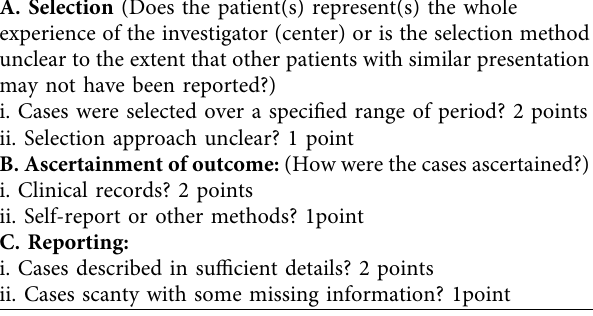
Table 1: Risk of bias assessment tool [19]]. A. Selection (Does the patient(s) represent(s) the whole experience of the investigator (center) or is the selection method unclear to the extent that other patients with similar presentation may not have been reported?)